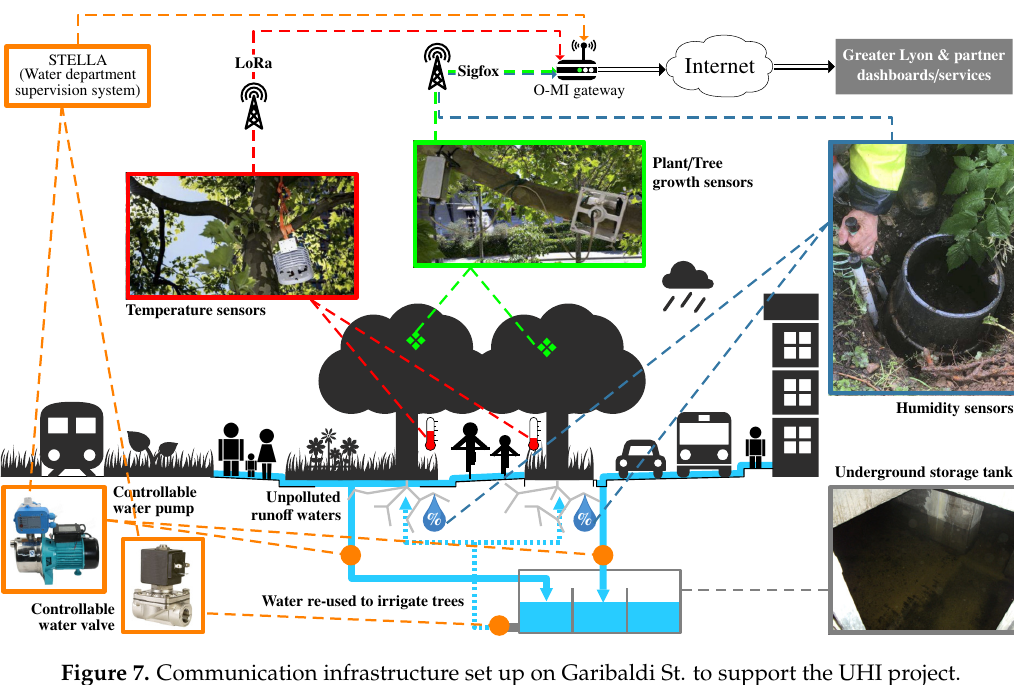
Figure 7. Communication infrastructure set up on Garibaldi St. to support the UHI project.